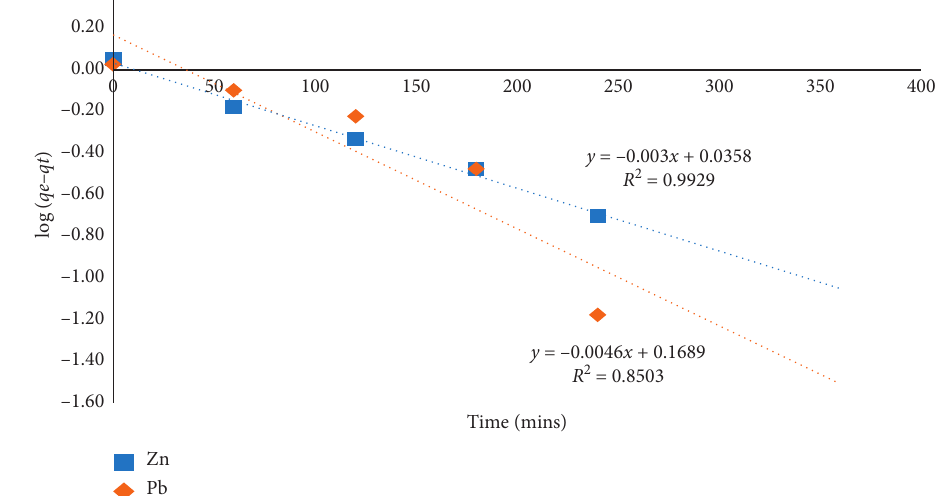
Figure 9: A graph of the pseudo-first-order kinetics for the removal of Zn 2+ and Pb 2+ from solution.